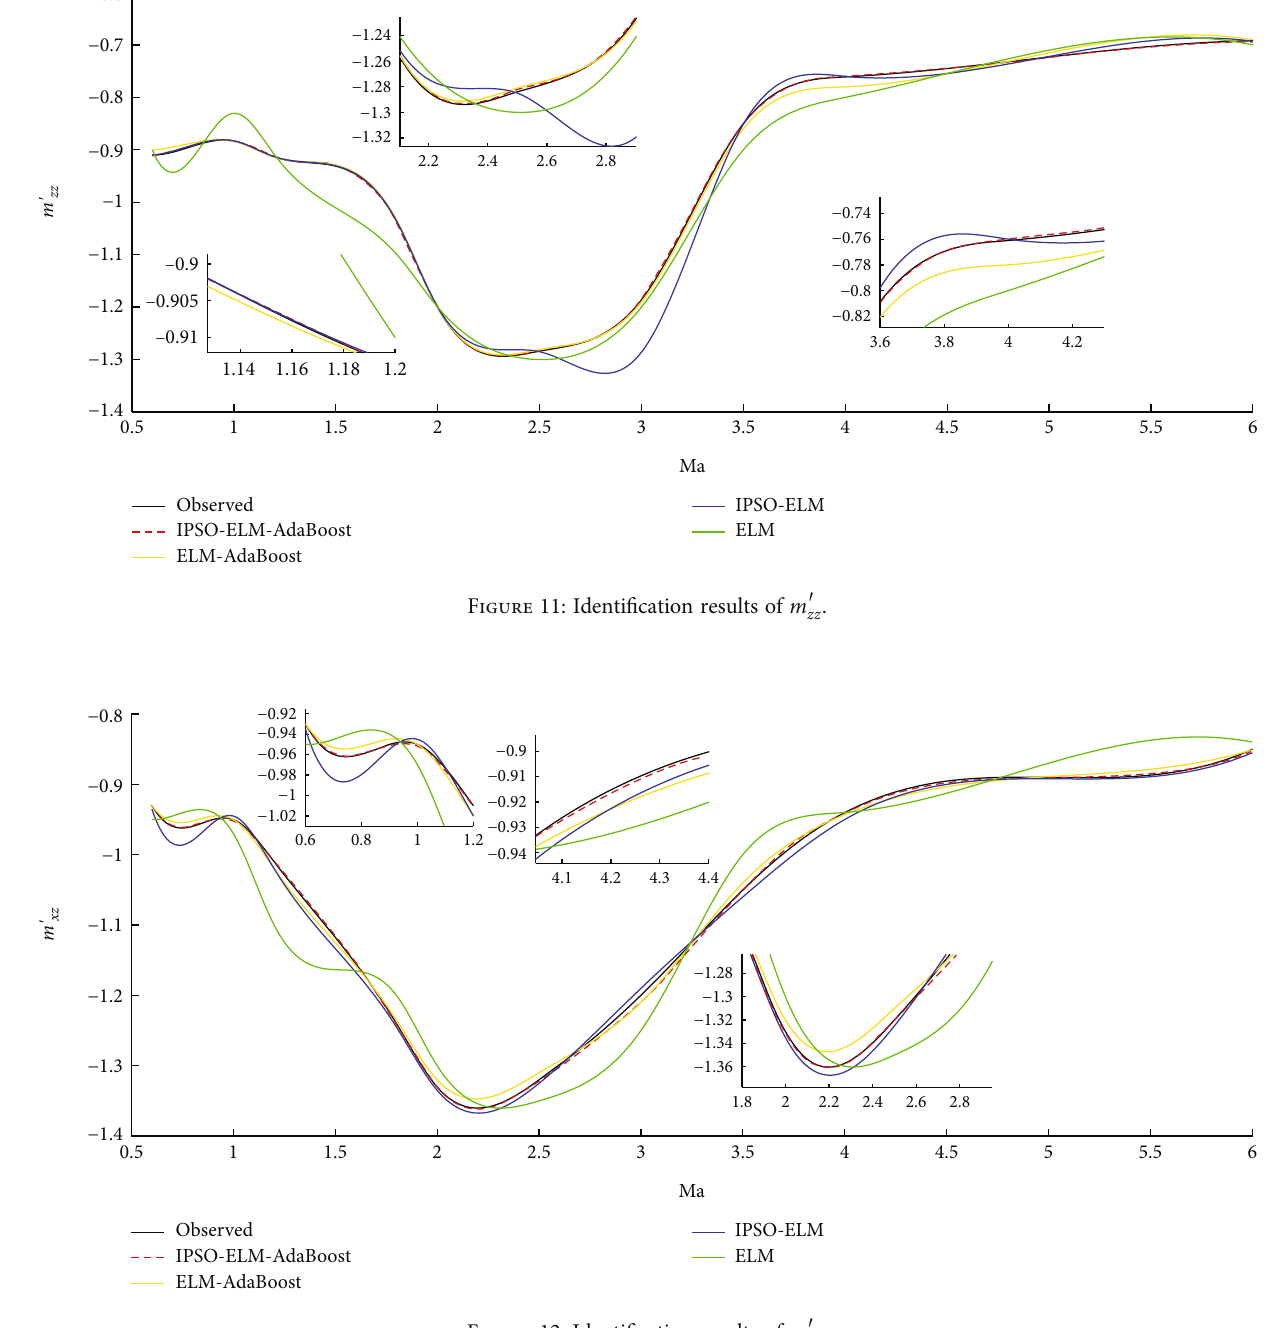
Figure 12: Identi fi cation results of m